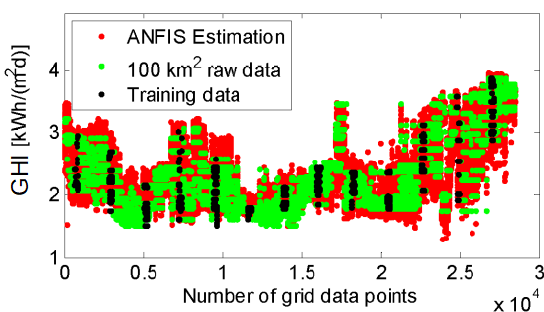
Figure 9. ANFIS radiation extrapolation compared to average (raw) and training